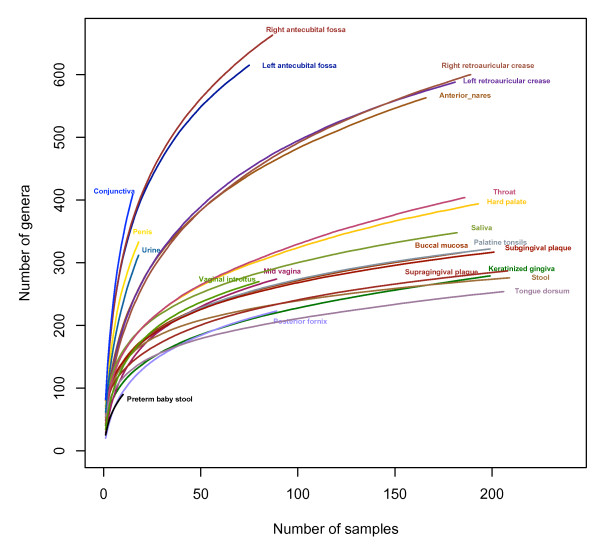
Accumulation curves of 22 habitats. Each line represents the accumulative richness from all subjects. All the reads were included in the analysis to have a full view of the genera revealed by the HMP and other datasets. At the genus level, oral, vaginal, and stool habitats become asymptotically flat at the current sampling depth and sampling efforts. More subjects are needed to reach the saturation for skin and skin-associated habitats.